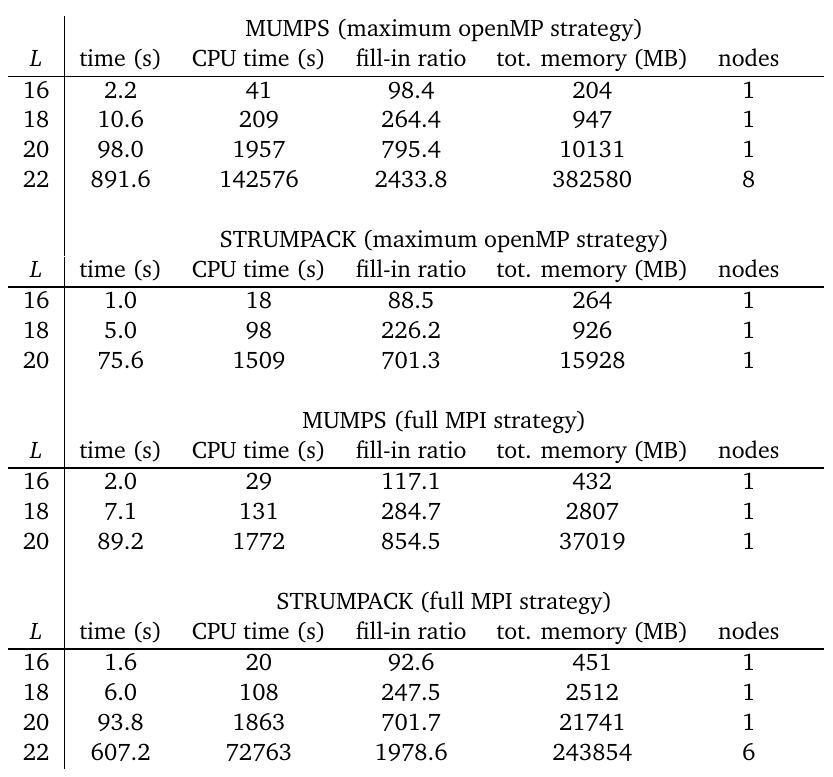
Table 2: Typical resources for the shift-invert computation. For the two solvers MUMPS and STRUMPACK, we report real execution time, total CPU time (sum of the execution time over all working CPUs), factorization fill-in ratios (ratio of the num- ber of nonzeros in the factors and in the original matrix to factorize), total memory occupation (as reported by the operating system) and minimum number of 60 GB compute nodes required. For sizes L ≤ 20 we show results both in the full openMP and in the full MPI setups. For L = 22 we use the optimal setup, i.e. a single pro- cess with the maximum number of openMP threads for MUMPS (which, for a higher number of processes, requires more memory and thus more compute nodes), and full MPI for STRUMPACK. MUMPS (maximum openMP strategy) L time (s) CPU time (s) fill-in ratio tot. memory (MB)